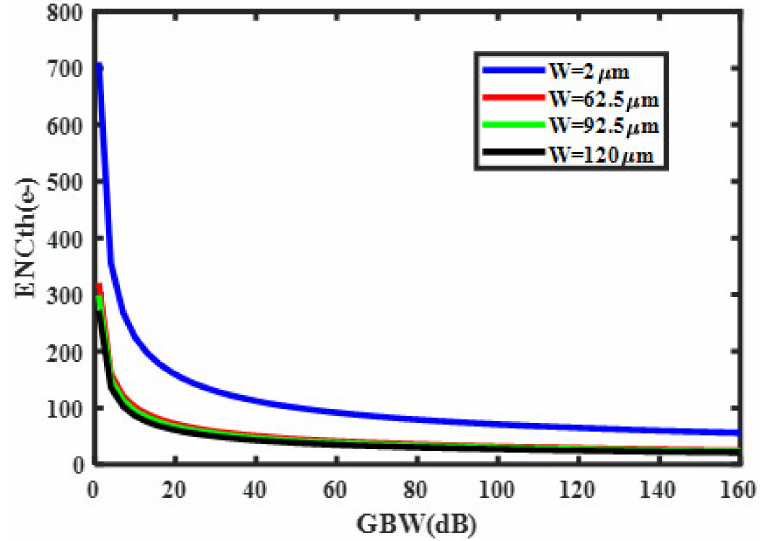
Figure 13. Effect of the CSA gain bandwidth (GBW) on ENCth for the different input gate